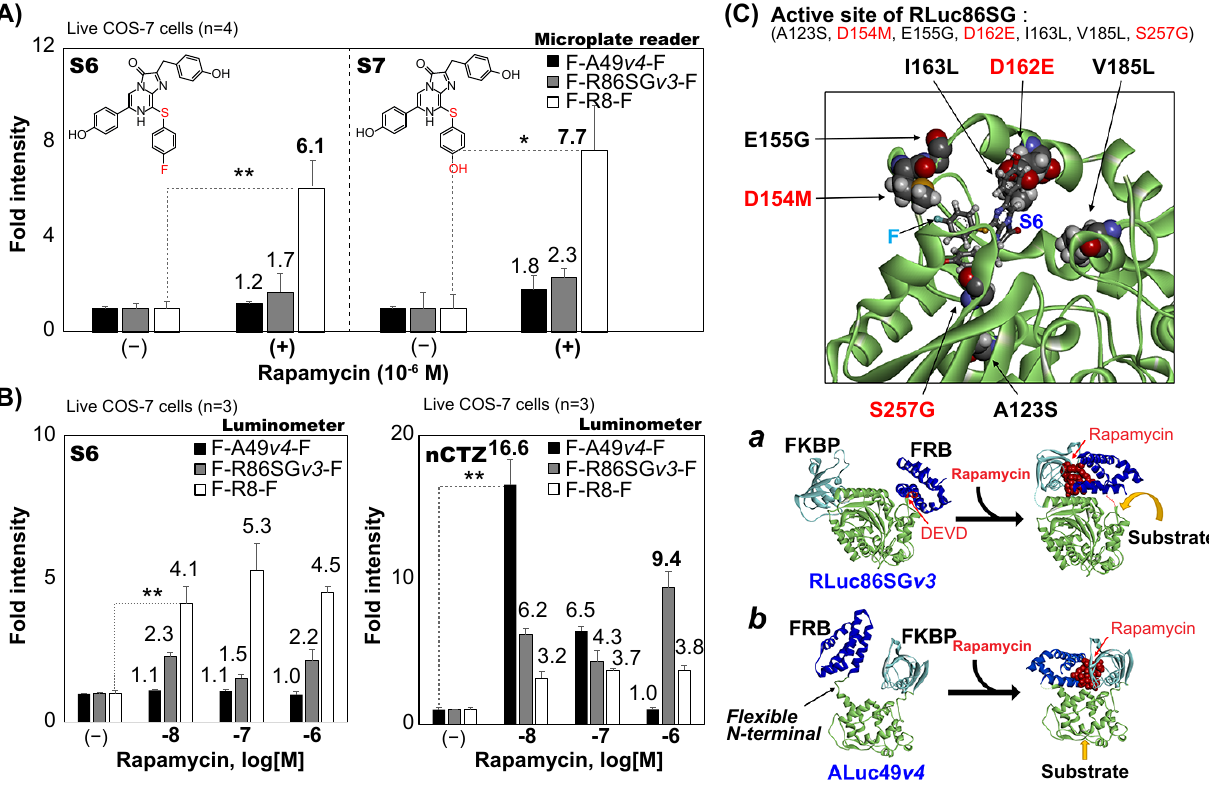
Fig. 5 New strain probes